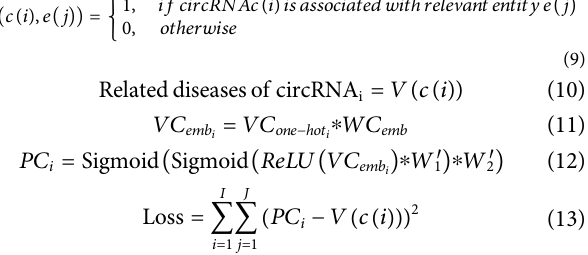
FIGURE 2 | The fl owchart of the Entity Relation Network (ERN). V one − hot feedforward neural network, and P i is the predicted probability vector of A(i), and V emb is embedding vector of entity A(i). One-hot encoding vector V one − hot speci fi c column of parameter matrix W emb as the embedding vector V emb of entity i, which is used for predicting the related entities. After training the embedding vector, i.e., the parameter matrix is